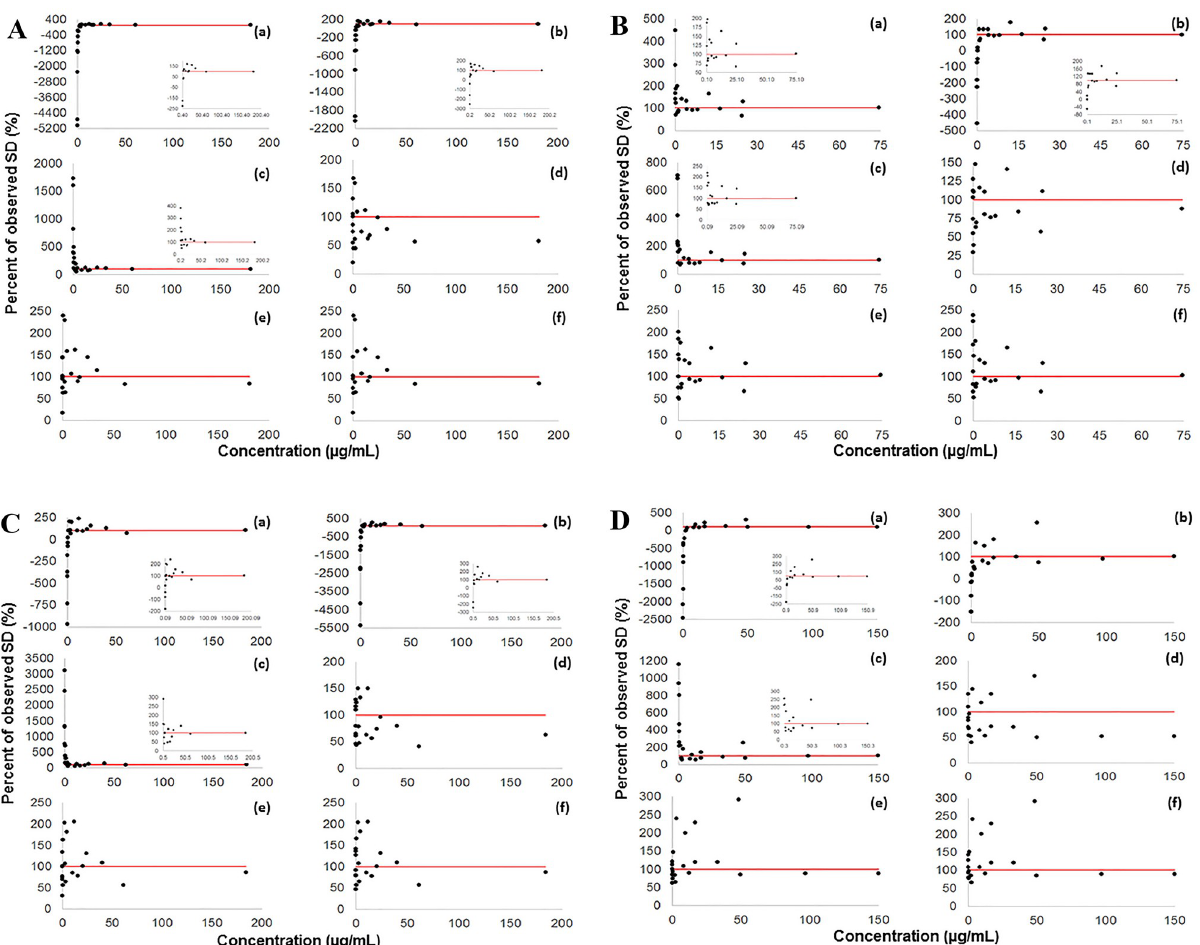
Fig 5. Accuracy of the prediction of SD’s by applying various regression algorithms to the final precision profiles of (A) carbamazepine, (B) fluconazole, (C) lamotrigine and (D) levetiracetam (M = 20 spiking levels+blank, N = 24 specimens/spiking level). Red lines indicate perfect (100%) agreement between predicted and experimentally determined SD’s. Insets show results for concentration ranges in which the inaccuracy of the predictions was on the same scale. The applied regression methods are (a) unweighted linear least squares, (b) unweighted 2 nd -order least squares, (c) unweighted 3 rd -order least squares, (d) 1/x 2 -weighted linear least squares, (e) Theil’s regression, (f) Theil’s regression with the Siegel estimator.